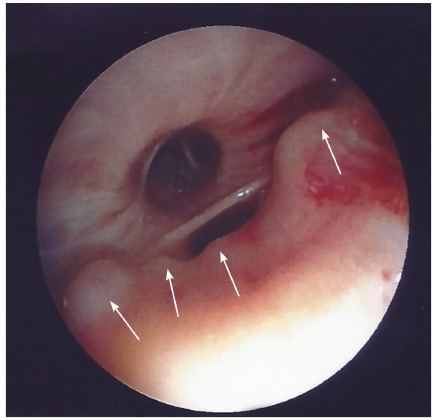
Figure 3: Bronchoscopic image of the patient’s right main bronchus showing unequal nodular protrusions of the